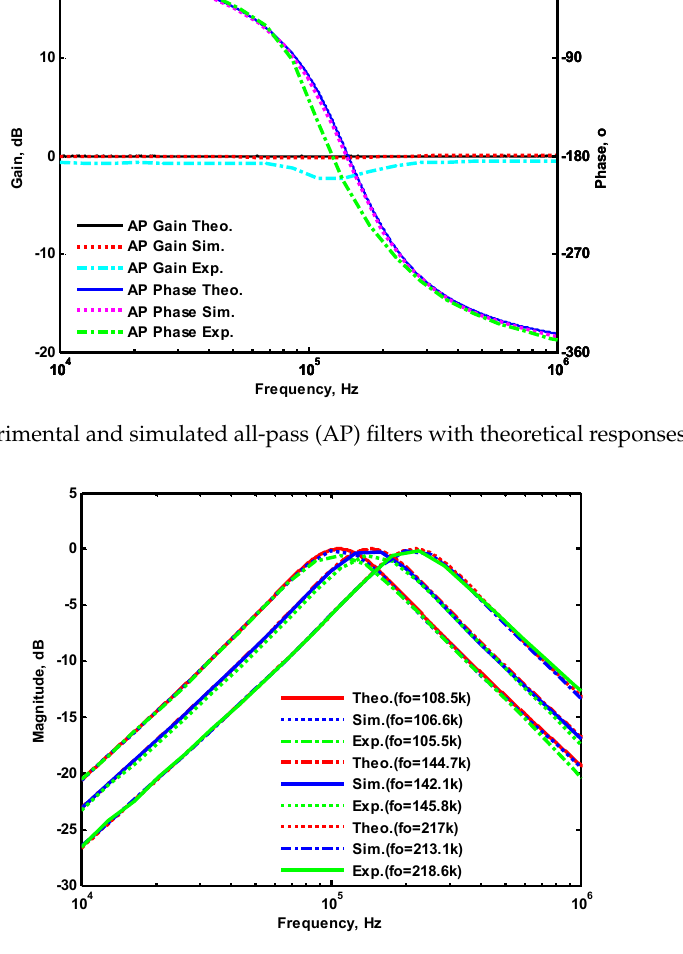
Figure 15. Theoretical, simulated, and measured gain responses of BP filters realized by varying f o while keeping Q.